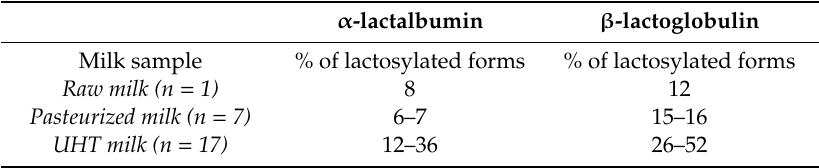
Table 1. Whey proteins quantification and percentages of lactosylated forms.